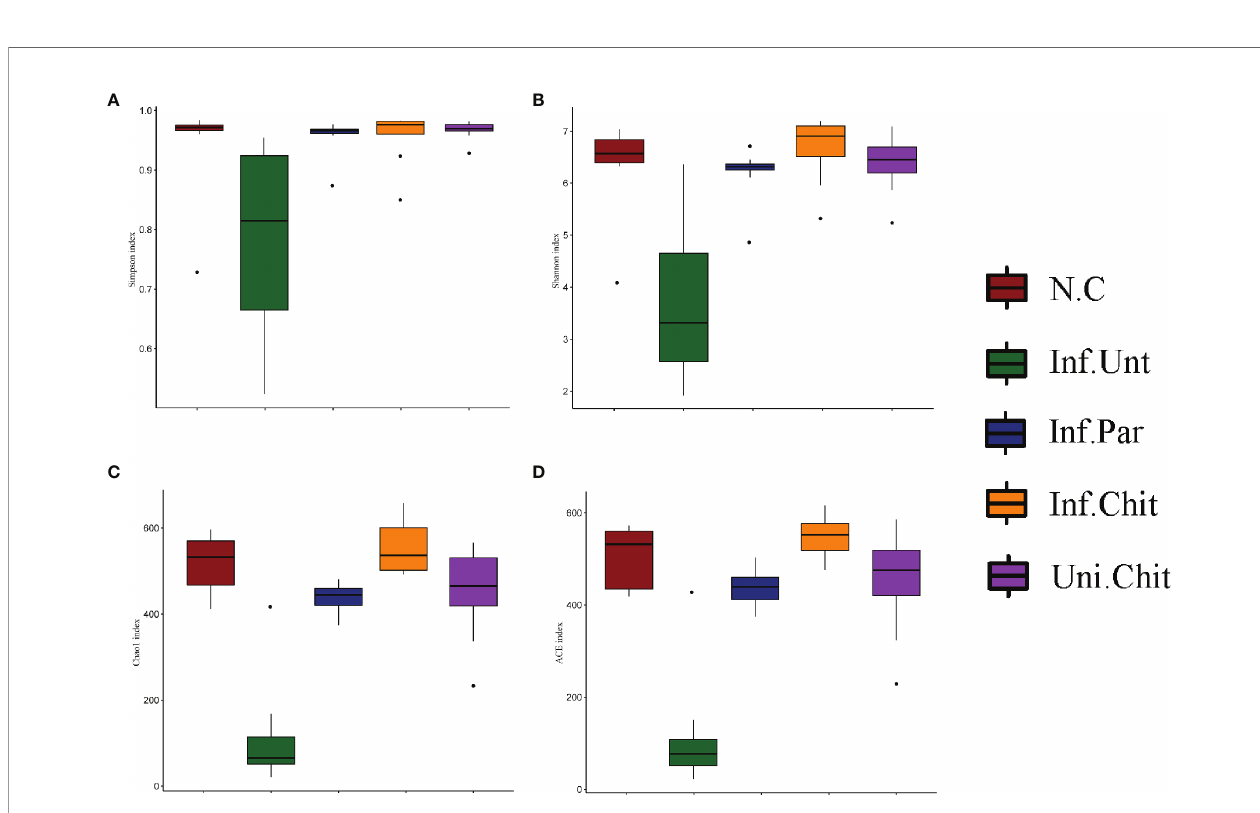
FIGURE 5 | Alpha diversity analysis of gut microbiota in C. parvum infected mice following chitosan interventions. (A, B) Bacterial diversity (C, D) Community